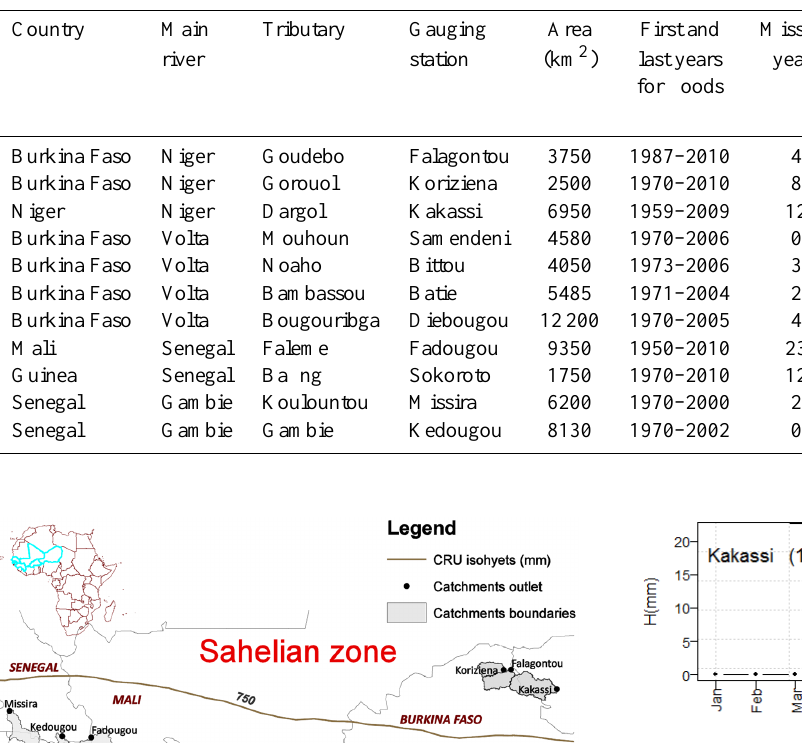
Table 1. General information on the 11 catchments and the flow and rainfall data sets used for the study. Annual rainfall is computed over the 1960–1999 period. Values of missing years recorded for the catchments Fadougou, Sokoroto, Missira and Kedougou represent the amount of reconstructed maximum discharge for these catchments.